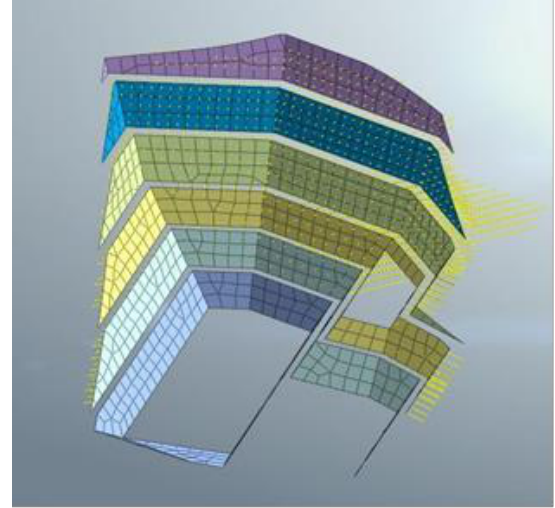
Figure 6. Anchor bar and anchor cable of the foundation pit system.